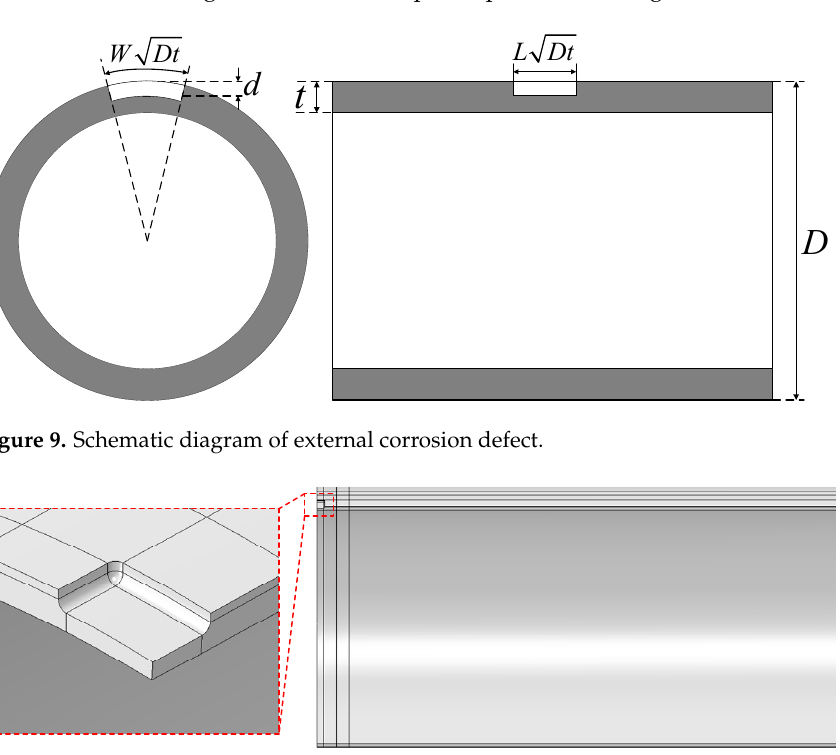
Figure 8. True stress–strain curve of X65 pipeline steel.